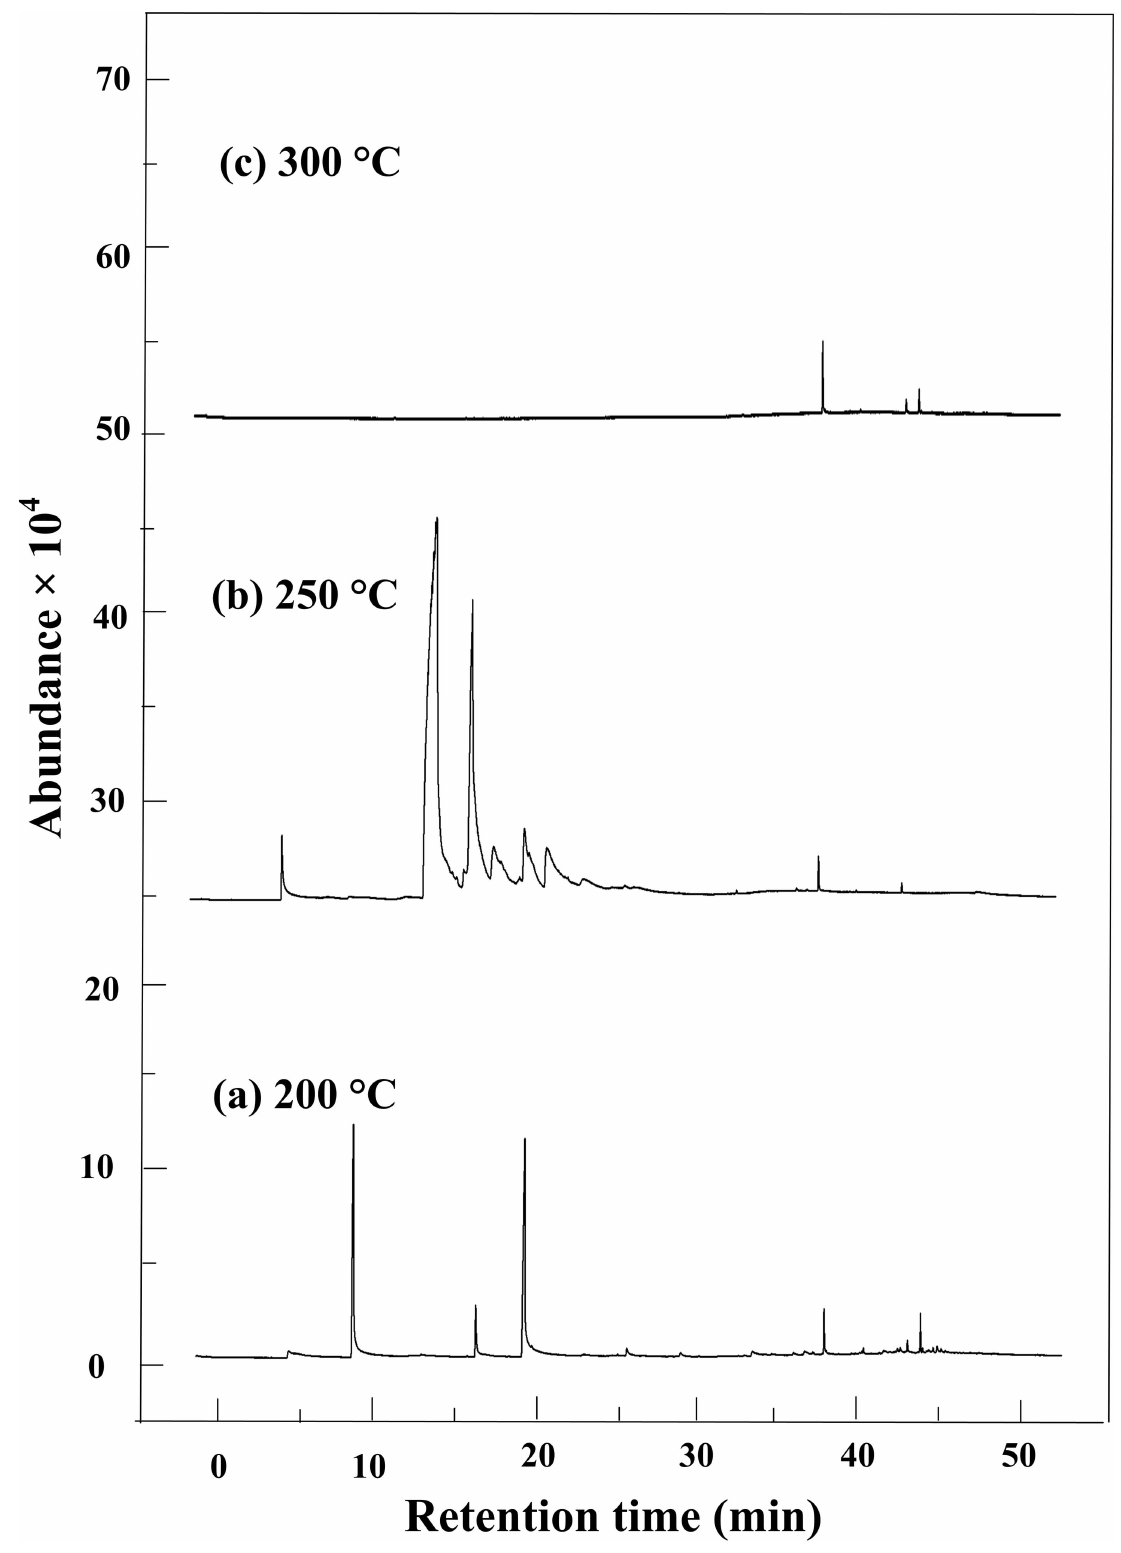
Fig 6. GC-MS spectra of organic byproducts from HTC reactions of lignin at three temperatures. (a) 200, (b) 250, (c) 300˚C.